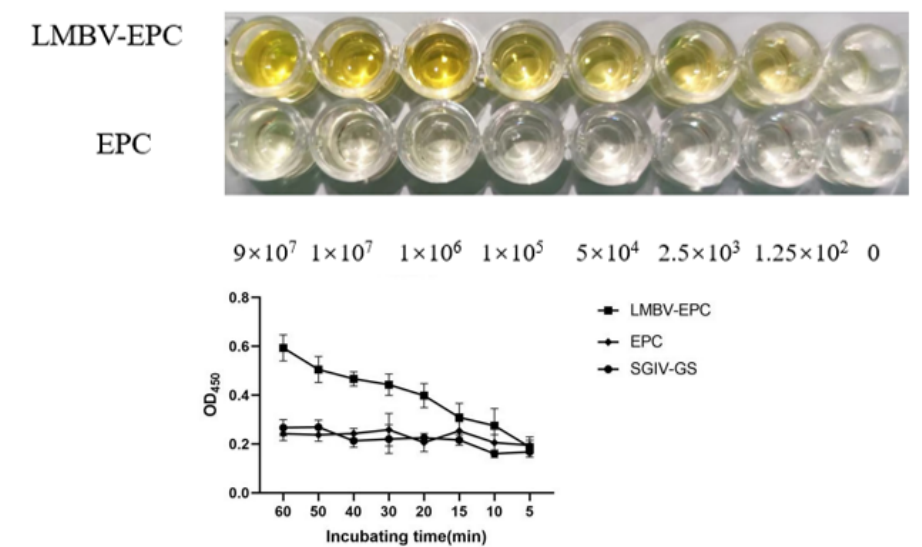
Figure 5. The sensitivity analysis of the sandwich ELASA: ( A ) The sandwich ELASA could detect as low as 1.25 × 10 2 cells/mL LMBV infected cells lysates. The SGIV-infected GS cells and uninfected EPC cells were used as the control. ( B ) Chromogenic reactions of LMBV-infected EPC lysates. ( C ) The sandwich ELASA detected LMBV infection with an incubation time as short as 10 min. The SGIV-infected GS cells and uninfected EPC cells as the controls.